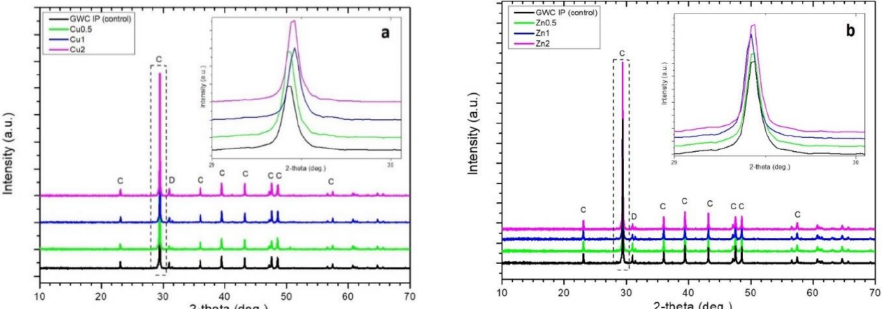
Figure 4. Powder X-ray diffraction patterns of GWC IPs (control) embedded with different amounts (0.5, 1%, and to 2%) of ( a ) CuO and ( b ) ZnO NPs; C: calcite; D: dolomite depict the match to the reference pattern of calcite, CaCO 3